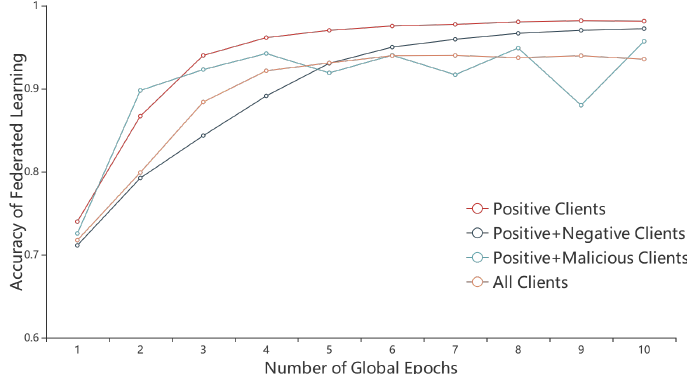
Figure 4. The effect of different types of client combinations on the accuracy of